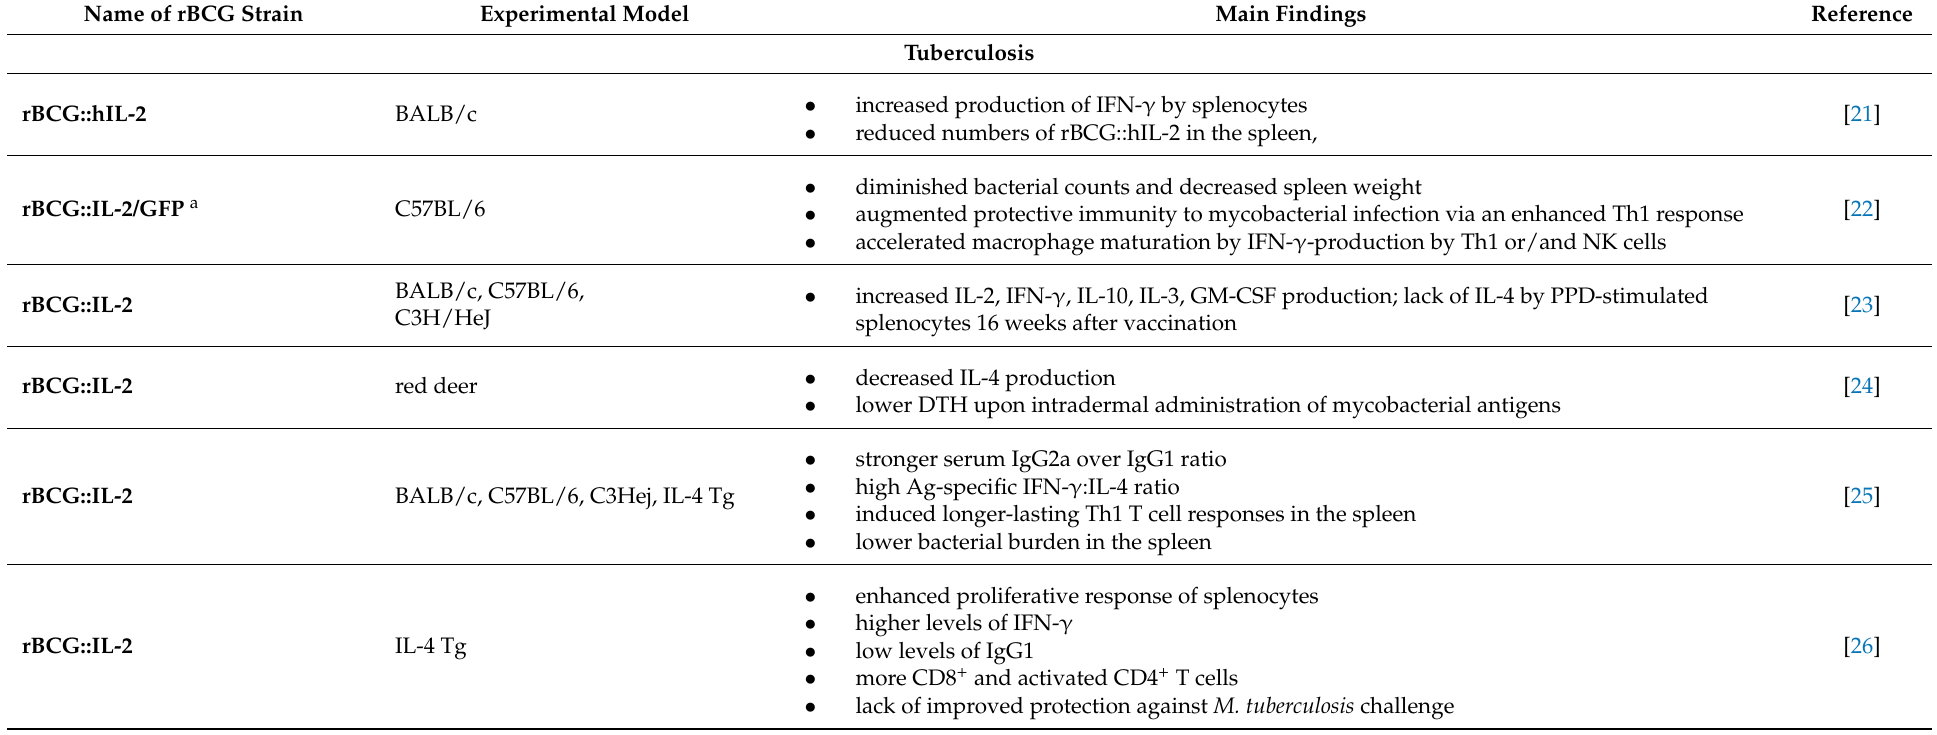
Table 1. Recombinant BCG producing cytokines in tuberculosis and non-tuberculosis